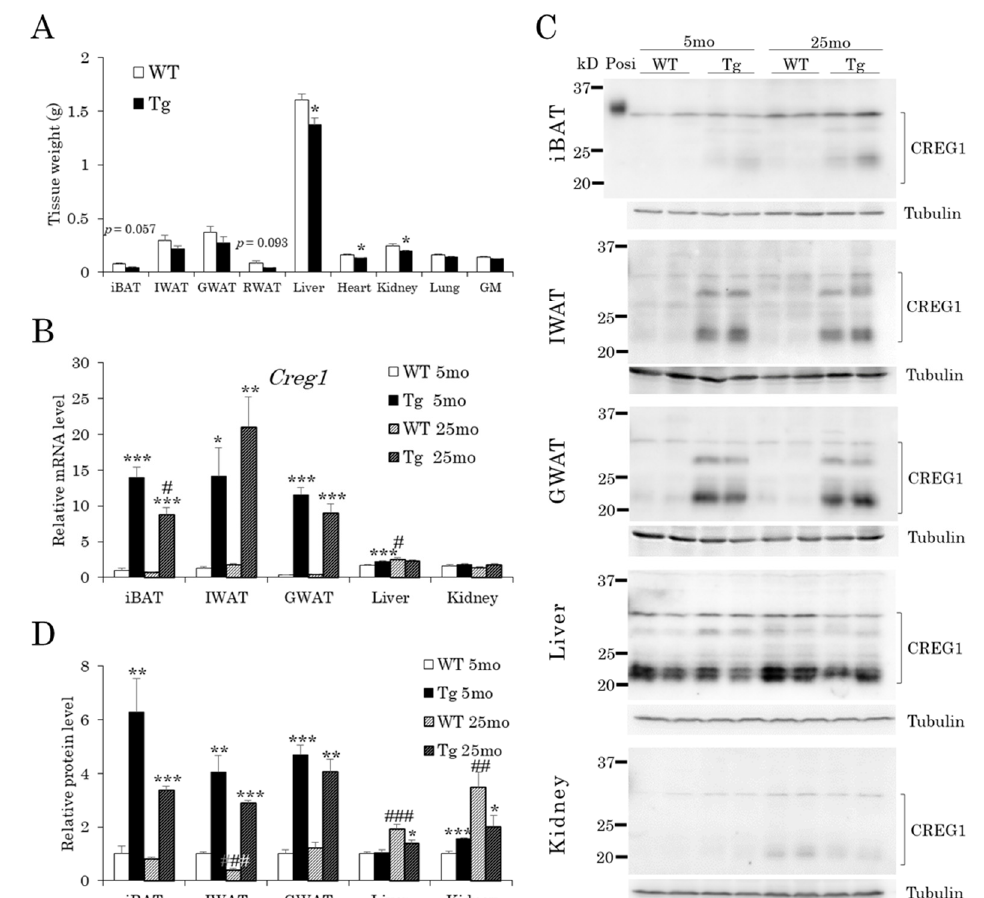
Figure 2. CREG1 expression levels in various tissues at 5 and 25 months. ( A ) Tissue weights. ( B ) mRNA expression of Creg1. ( C ) Western blotting for CREG1. ( D ) Relative protein level of CREG1 in ( C ). Positive control (Posi): mCREG1-MH; Tubulin: 55 kD. CREG1 levels were normalized to tubulin levels. Representative images are shown. iBAT: interscapular brown adipose tissue, IWAT: inguinal white adipose tissue, GWAT: gonadal white adipose tissue, RWAT: retroperitoneal white adipose tissue, GM: gastrocnemius muscle. Data are means ± SEM ( n = 4–5). * p < 0.05, ** p < 0.01, *** p < 0.001 vs. WT at the same time point; # p < 0.05, ## p < 0.01, ### p < 0.001 vs. ( B – D ) 5 months for the same genotype.